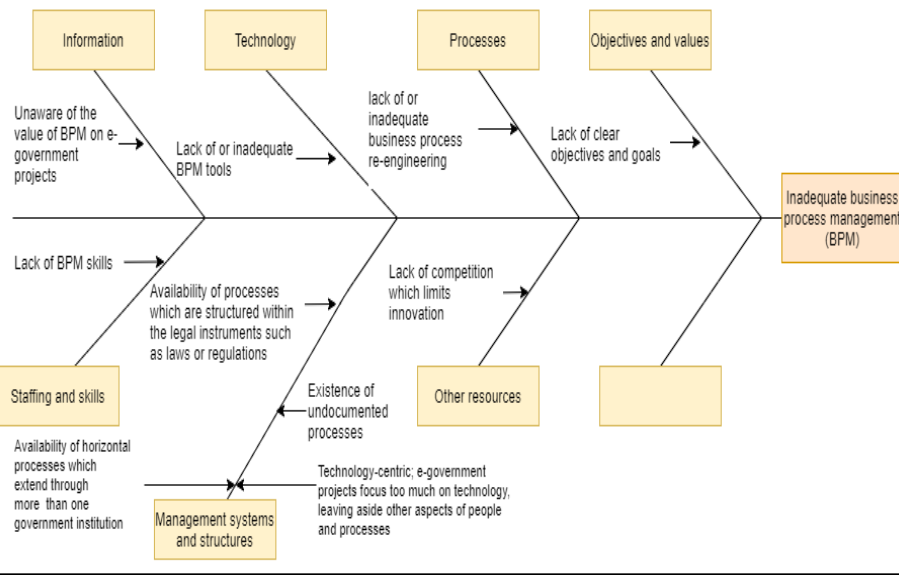
Figure 10: Inadequate business process management (BPM)